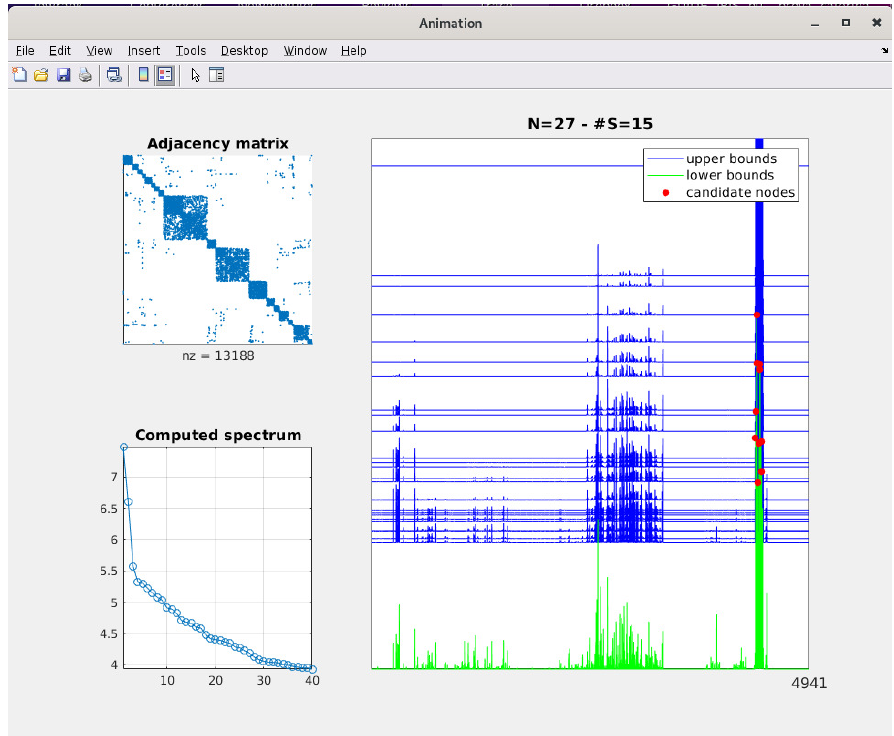
Figure 3. The animation window after the identification of the five most important nodes for the Power network by the hybrid